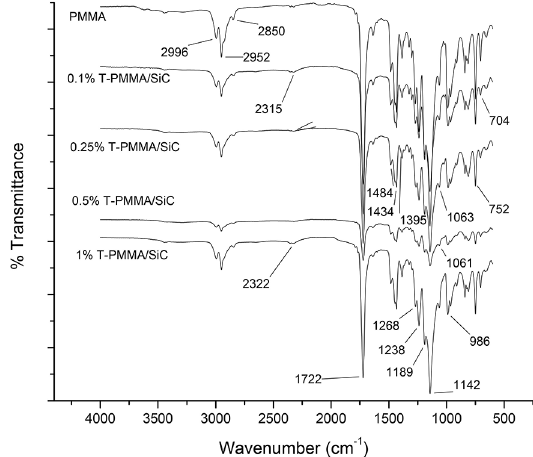
Figure 3. FTIR spectra of the nanocomposite samples, 0.1, 0.25, 0.5 and 1% of treated SiC fillers, respectively.